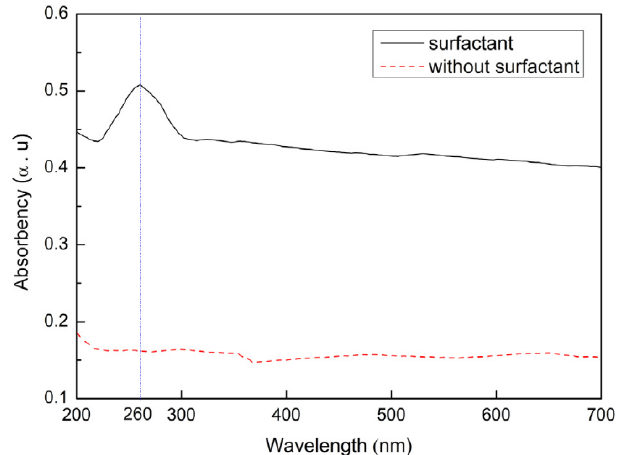
Figure 8. UV-Vis spectroscopy of graphene suspensions with and without surfactants. Reprinted with permission from Ref. [69]. Copyright 2018